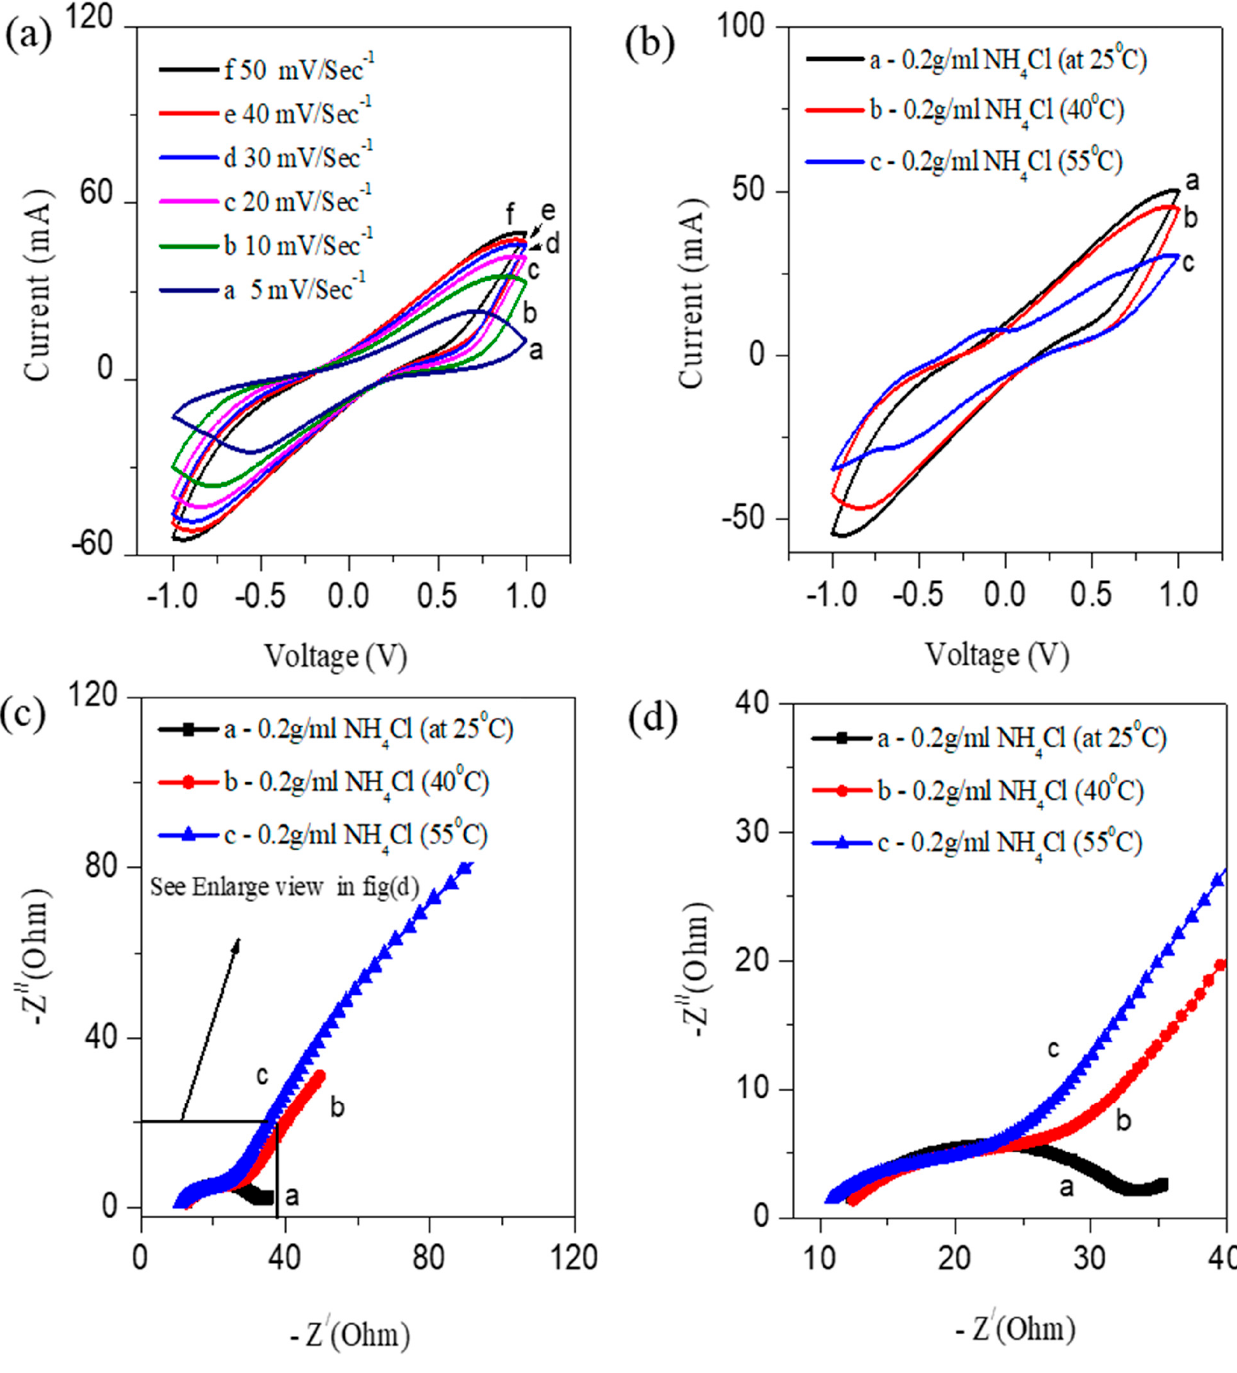
Figure 3. Effect of temperature on the electrochemical properties of CS-AFC with 0.2 g/mL NH 4 Cl fuel concentration with ferricyanide. ( a ) Scan rate variation of the CS-AFC; ( b ) C–Vs recorded at different temperatures. ( c ) EIS data of the temperature dependence of the CS-AFCs. ( d ) Enlarged view of the Nyquist plots.